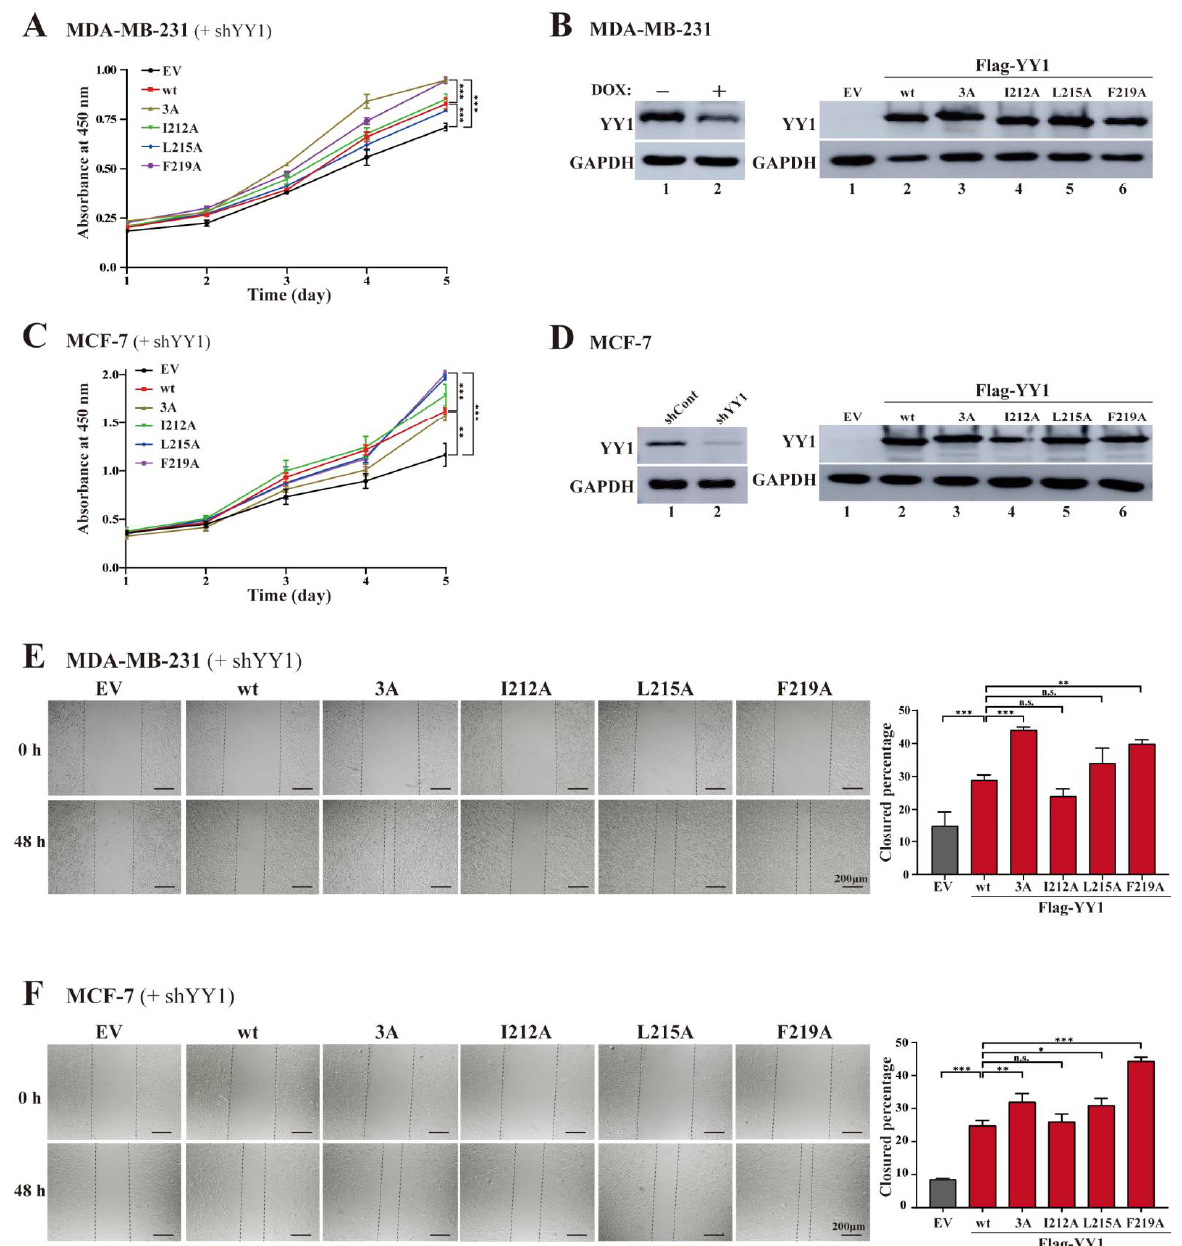
Figure 4. Effects of the OPB mutations on cell proliferation and migration of breast cancer cells. ( A – D ) Effects of ectopic expression of Flag-YY1 wt and its OPB mutants on the proliferation of breast cancer cells. MDA-MB-231 cells carrying a TET-inducible shYY1 targeting the YY1 mRNA 3′-UTR cultured in doxycycline (DOX)-containing medium ( A ), or MCF-7 cells infected by lentivirus carrying the same shYY1 ( C ), were infected by lentivirus expressing Flag-YY1 wt and mutants, followed by WST-1 assay, to determine cell proliferation. Endogenous YY1 knockdown and ectopic expression of YY1 wt and mutants in MDA-MB-231 and MCF-7 cells are shown in ( B , D ), respectively. ( E , F ) Scratch assays to test the effects of YY1 mutants on breast cell migration. Endogenous YY1 knockdown and ectopic YY1 expression in MDA-MB-231 ( E ) and MCF-7 ( F ) cells carried out as described in ( A – D ). Images were captured when scratches were just made on the plates of overnight cultured cells and after 48 h of culture in the presence of 1.0 µ M of Mitomycin C. The quantitation of cell migration is shown at the right panels. Data represent the mean ± S.D., n.s.: no significance, * p < 0.05, ** p < 0.01 and *** p <